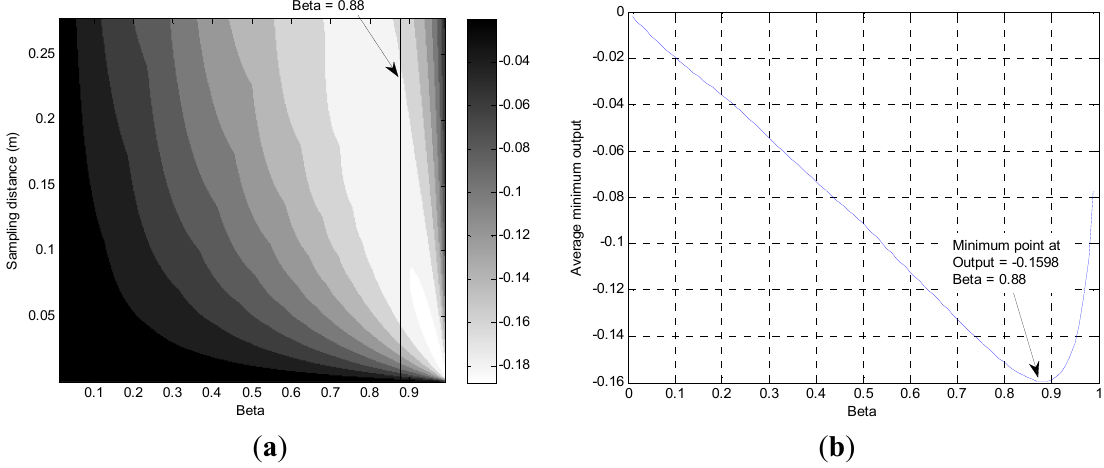
Figure 9. ( a ) Minimum system output distribution in terms of β and SD; ( b ) Averaged minimum system output over SD in terms of β